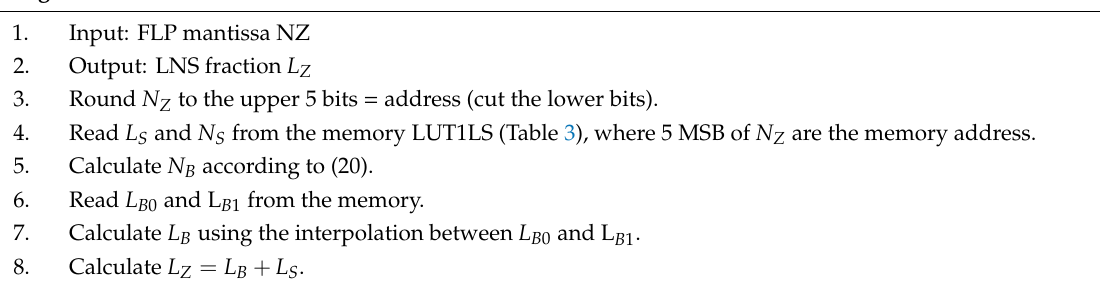
Algorithm 2 RISC conversion from N to L